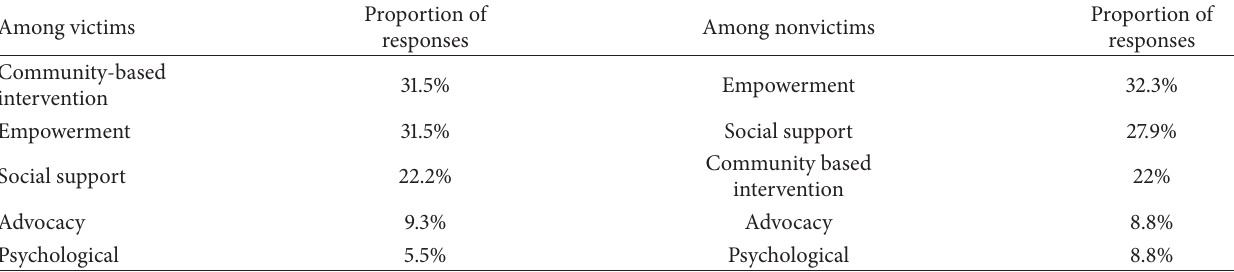
Table 3: Similarities and differences on perceived preferences of intervention components between victims and nonvictims groups.